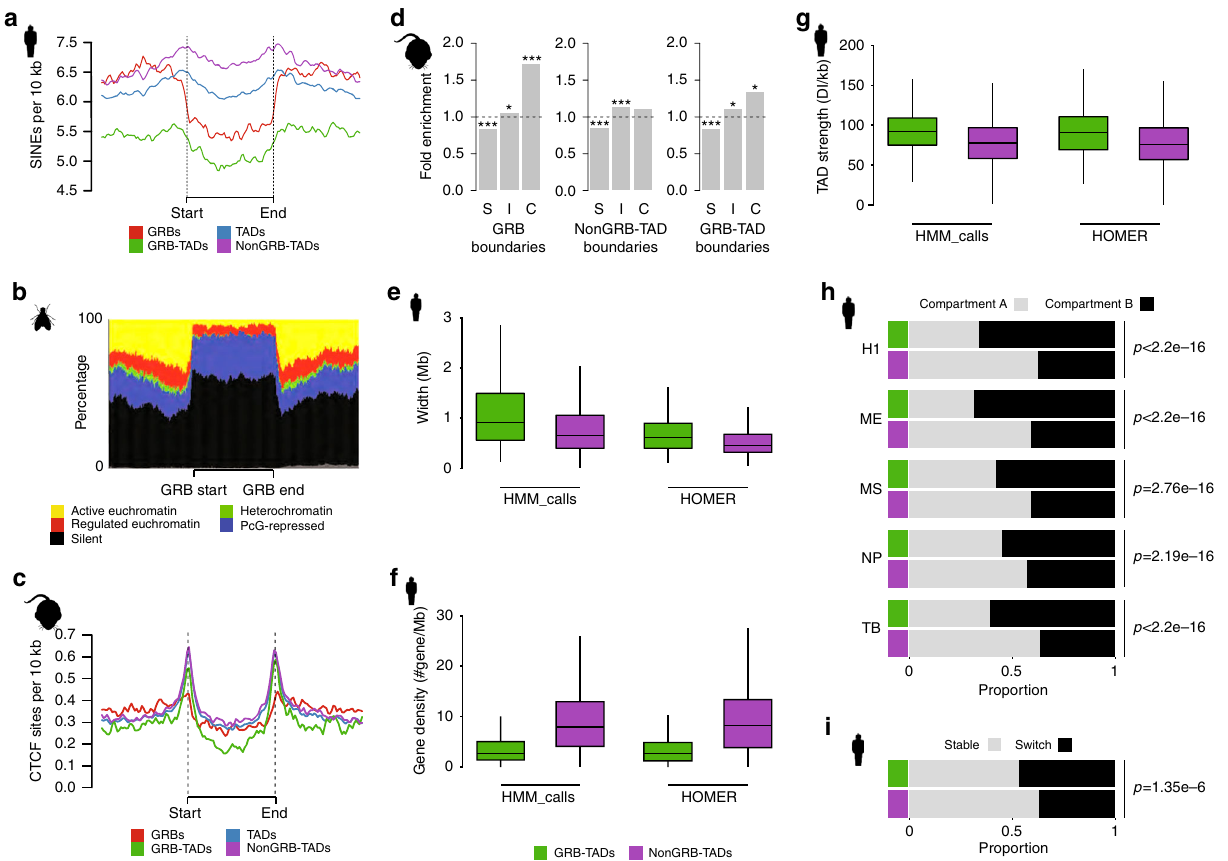
Fig. 4 Several sets of features distinguish between TADs associated with extreme conservation from those without. a Depletion of SINE elements within GRB-TADs compared to non-GRB-TADs (using H1 HOMER TADs) re fl ects the selective constraint on these regions against the retention of repeat element insertion. b GRBs in Drosophila Kc167 cells are mainly associated with inactive ( black ) and Polycomb-repressed chromatin ( blue ) and represent functionally coherent regions. Active and regulated chromatin correspond to different types of euchromatin. There appears to be a change in the proportion of constitutively active chromatin ( yellow ) at the boundary regions identi fi ed as GRBs. c CTCF sites are depleted within GRBs. CTCF sites per 10 kb plotted across GRBs and fl anking regions of equivalent size to the GRBs normalised to show signal relative to GRB boundaries and Loess-smoothed. d Enrichment for different patterns of CTCF binding at different genomic features ( S peci fi c, I ntermediate, C onstitutive). Constitutive CTCF peaks are enriched within 10 kb of both GRBs and GRB-TAD boundaries (binomial test p -values: * p < 0.05, ** p < 0.01, *** p < 0.001). e Distribution of TAD width reveals GRB-TADs are signi fi cantly longer than non-GRB-TADs identi fi ed in human H1 cells using either HOMER (median width 620 kb vs. 460 kbp, p < 1e − 6) or HMM_calls (median width 920 vs. 680 kb, p < 1e − 6). f Human H1 GRB-TADs are associated with lower protein-coding gene density than non-GRB-TADs identi fi ed using HOMER (median no. genes 2.63 vs. 8.33 p < 1e – 6) or HMM_calls (median no. of genes 2.65 vs. 8.33 p < 1e − 6). g GRB-TADs are signi fi cantly stronger than non-GRB-TADs identi fi ed in human H1 cells using HOMER (median strength 90.88 vs. 75.81, p < 1e − 6) or HMM_calls (median